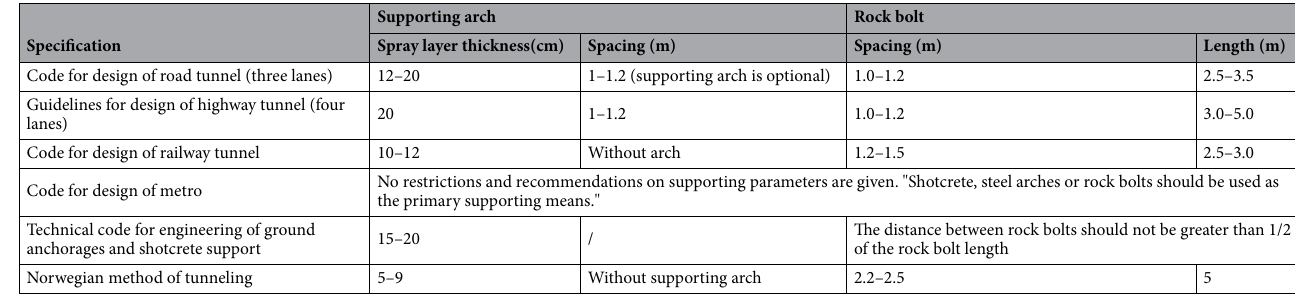
Table 3. Suggestions on initial support parameters given in the codes for surrounding rock of grade